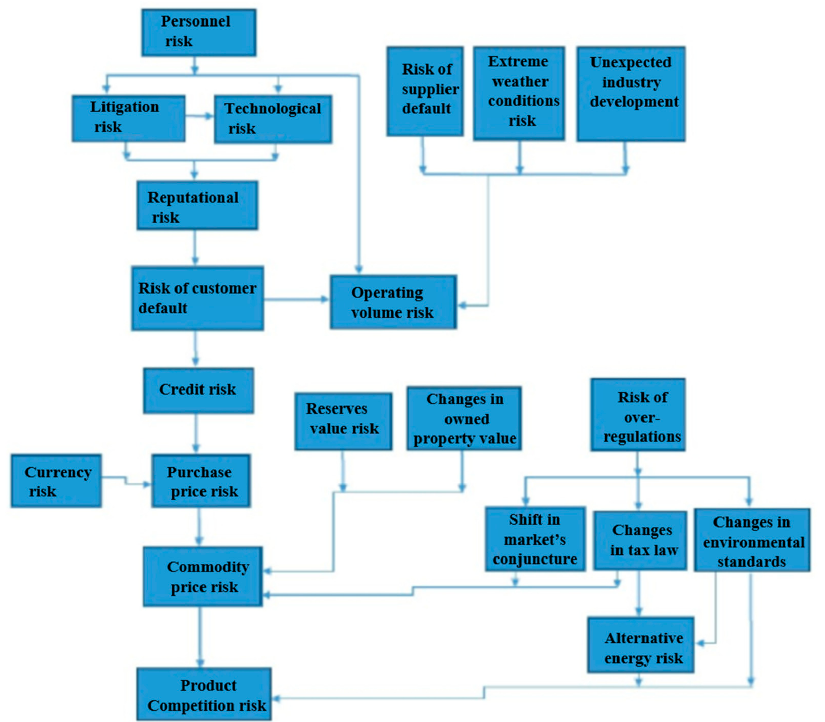
Figure 1. The risk map of gas trading companies. Source: own work.